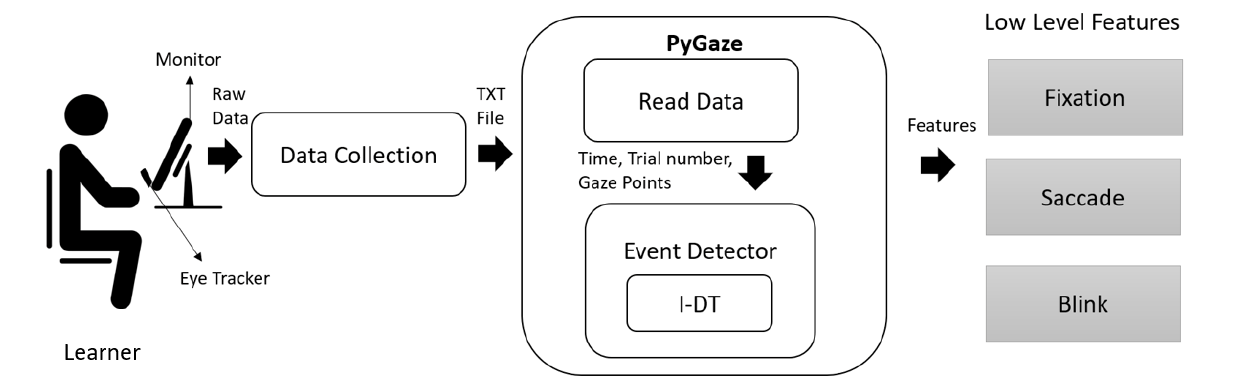
Figure 2. Low Level Feature